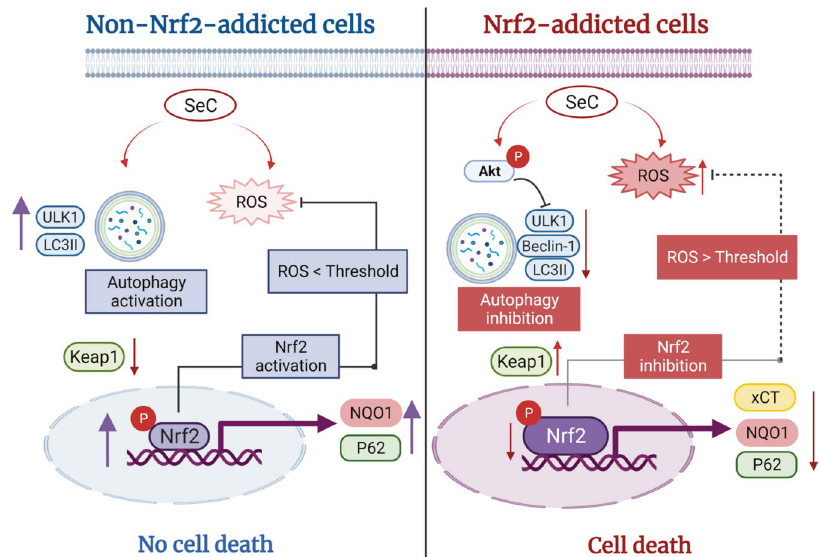
Fig. 8 Selective inhibition of Nrf2 and autophagy due to SeC in Nrf2-addicted CRC cells. In non – Nrf2-addicted cells, SeC induced slightly low ROS levels and then effectively triggered Nrf2 and autophagy activations. The autophagic proteins, such as ULK1 and LC3II, increased in the SeC-treated non-Nrf2-addicted cells. SeC induced Nrf2 activation and translocation, resulting in NQO1 and HO-1 increasing in the non – Nrf2-addicted cells. Therefore, the ROS was below the threshold level and no cell death occurred. By contrast, SeC induced ROS prodiction and inhibited the Nrf2 and autophagy pathways in Nrf2-addicted cells. The antioxidative enzymes xCT and NQO1 were decreased by SeC. SeC inhibits Nrf2 activation, which may lead to anoverwhelming ROS accumulation, subsequently triggering cell death. P